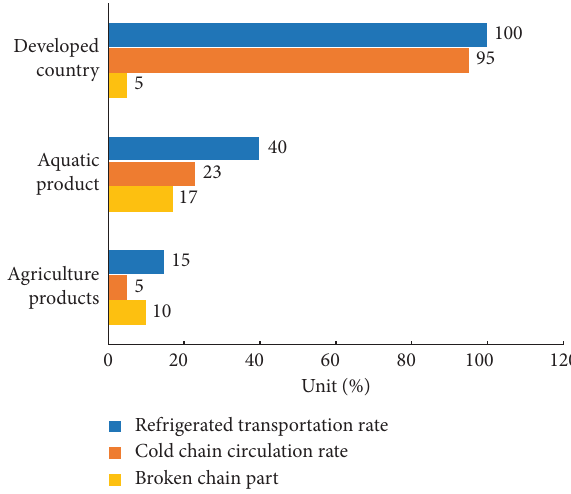
Figure 1: Transportation and circulation of cold chain logistics at home and abroad. Source: public data